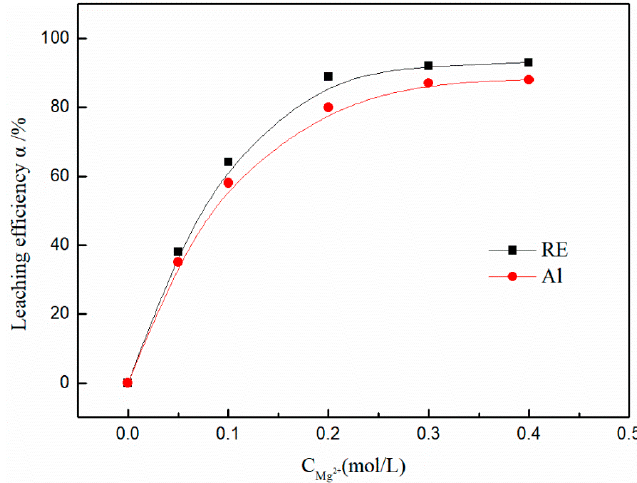
Figure 4. The effect of magnesium sulfate concentration on the leaching efficiency of rare earth and aluminum (250 g ore; liquid: solid = 1.2:1; flow rate = 0.5 mL/min; pH = 5.6; room temperature).